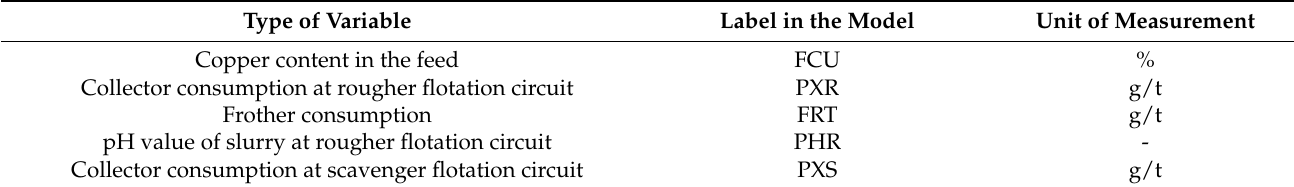
Table 1. Input (independent) parameters.